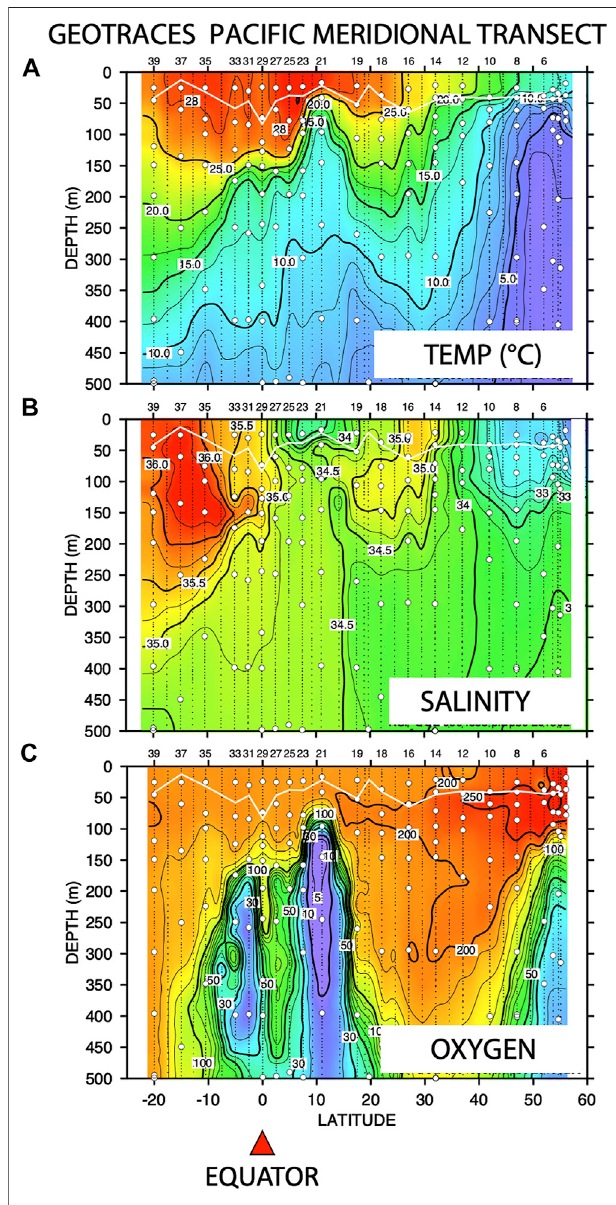
FIGURE 7 | GEOTRACES GP15 Meridional Transect distributions of (A) temperature, (B) salinity, and (C) oxygen from surface to 500 m from the GTC